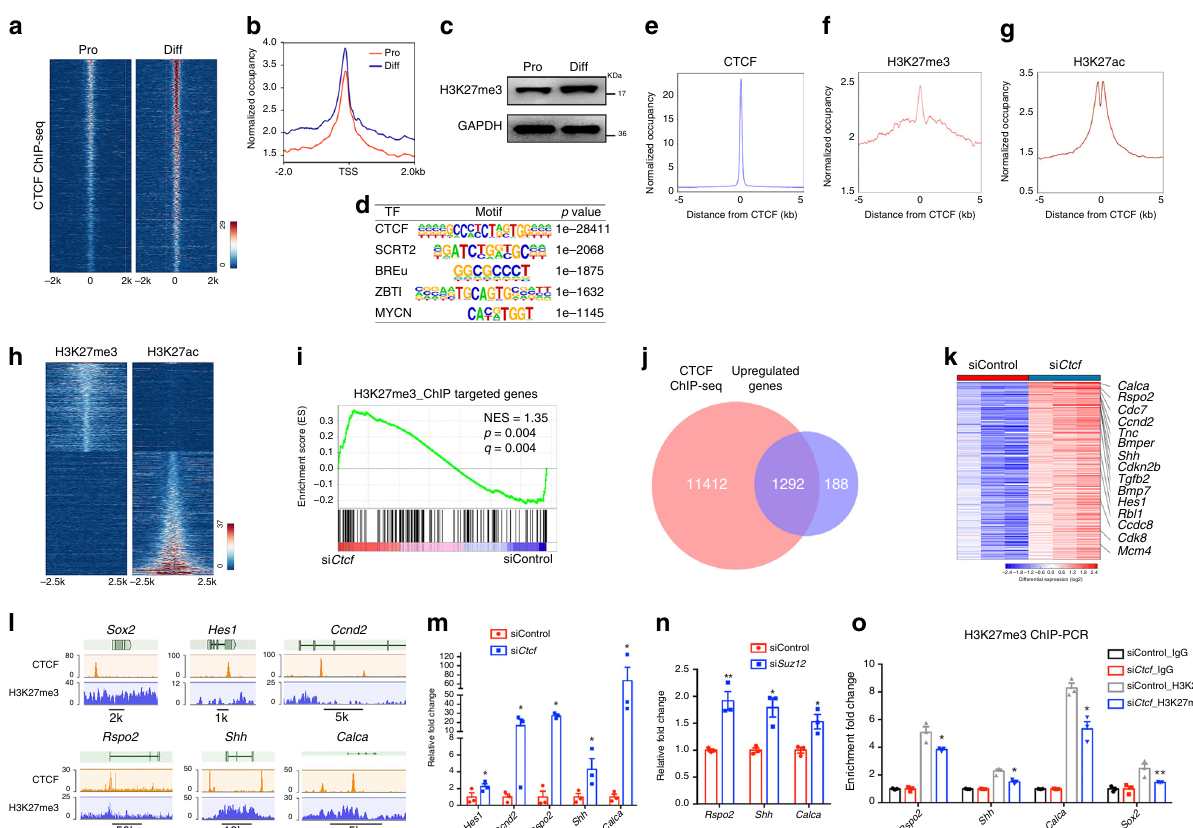
Fig. 9 CTCF and SUZ12 regulate transcriptomic dynamics during SC differentiation. a Heatmap of CTCF ChIP-seq peaks from proliferating and differentiated SCs. n = 1 in each condition. b ChIP-seq enrichment around TSS regions in proliferative and differentiated SCs. c Immunoblotting for H3K27me3 in proliferating and differentiating SCs. n = 2 independent experiments. d Enriched motifs of transcription factors (TF) in the CTCF-bound regions. e – g ChIP-seq enrichment around CTCF binding regions for e CTCF, and g H3K27ac in rat SCs, f H3K27me3 in rat sciatic nerves. h Heatmap for H3K27me3 and H3K27ac. The sites are ranked in ascending order of H3K27ac intensity. n = 1 in each condition. i GSEA enrichment for genes with H3K27me3 peaks associated with TSSs in siControl or si Ctcf rat SCs. NES, normalized enrichment score. j Overlap between CTCF-bound and upregulated genes differentially expressed in rat SCs treated with control siRNA or si Ctcf . k Heatmap of CTCF-targeted upregulated genes in rat SCs treated with control siRNA or si Ctcf . n = 3 in each condition. l Tracks for the indicated genes with ChIP-seq of CTCF from rat SCs and of H3K27me3 from rat sciatic nerves. n = 1 in each condition with 20 million cells. m Expression of the indicated genes in RNA-seq dataset from rat SCs treated with control siRNA or si Ctcf . n = 3 independent experiments, P ( Hes1 ) = 0.011, P ( Ccnd2 ) = 0.01007, P ( Rspo2 ) = 0.0105, P ( Shh ) = 0.019, P ( Calca ) = 0.041. n qRT-PCR for the indicated genes in rat SCs treated with control siRNA or si Suz12 . n = 3 independent experiments, P ( Rspo2 ) = 0.006, P ( Shh ) = 0.012, P ( Calca ) = 0.02. o ChIP-qPCR for H3K27me3 at the promoters of the indicated genes in rat SCs treated with control siRNA or si Ctcf . IgG were normalized to 1; n = 3 independent experiments, P ( Rspo2 ) = 0.039, P ( Shh ) = 0.011, P ( Calca ) = 0.039, P ( Sox2 ) = 0.0094. Data are presented as means ± SEM, * P < 0.05, ** P < 0.01, *** P < 0.001, two-tailed unpaired Student ’ s t -test. Source data are provided as a Source Data differentiating SCs. The signals of CTCF peaks within ±2 kb elements proximal to transcriptional start sites appeared to have (Fig. 9a, b), accompanied by increased levels of H3K27me3 in differentiating SCs (Fig. 9c). To identify consensus sequence